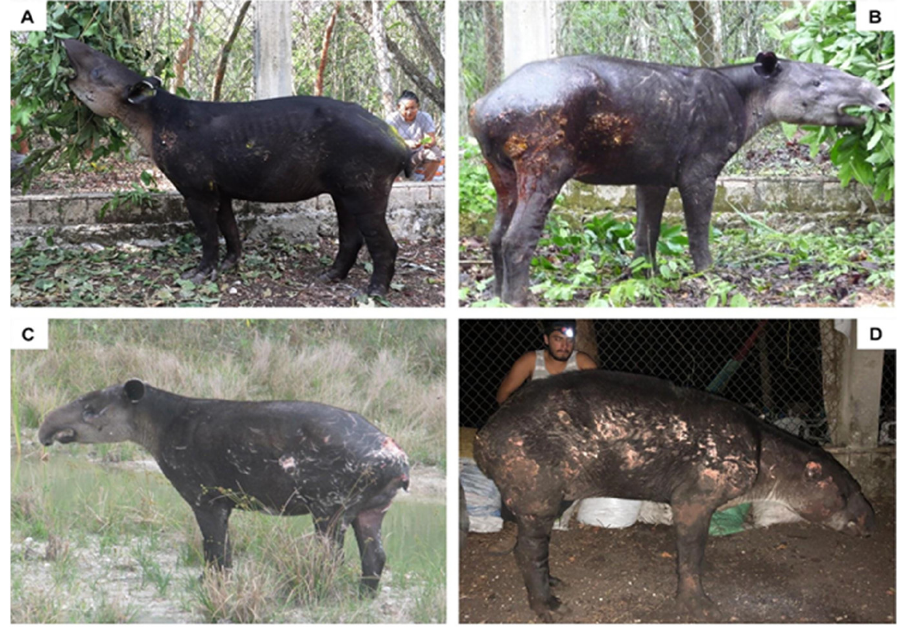
Figure 3. Tapirs injured sighted in settlements of Calakmul, Mexico. Tapirs presented different levels of severity of injuries. ( A ) Female tapir found in the settlement of Nueva Vida in 2017; ( B ) Male tapir found close to the settlement of Alvaro Obregon in 2015; ( C ) Male tapir sighted close to the settlement of 20 de Noviembre in 2020; and ( D ) Male tapir close to the settlement of Once de Mayo in 2019. Table 1. Classification of tapir sightings according to the distance to the nearest human settlement where they were recorded. HS = human shield, HA = human activity and LHA = low human activity. Number of Area